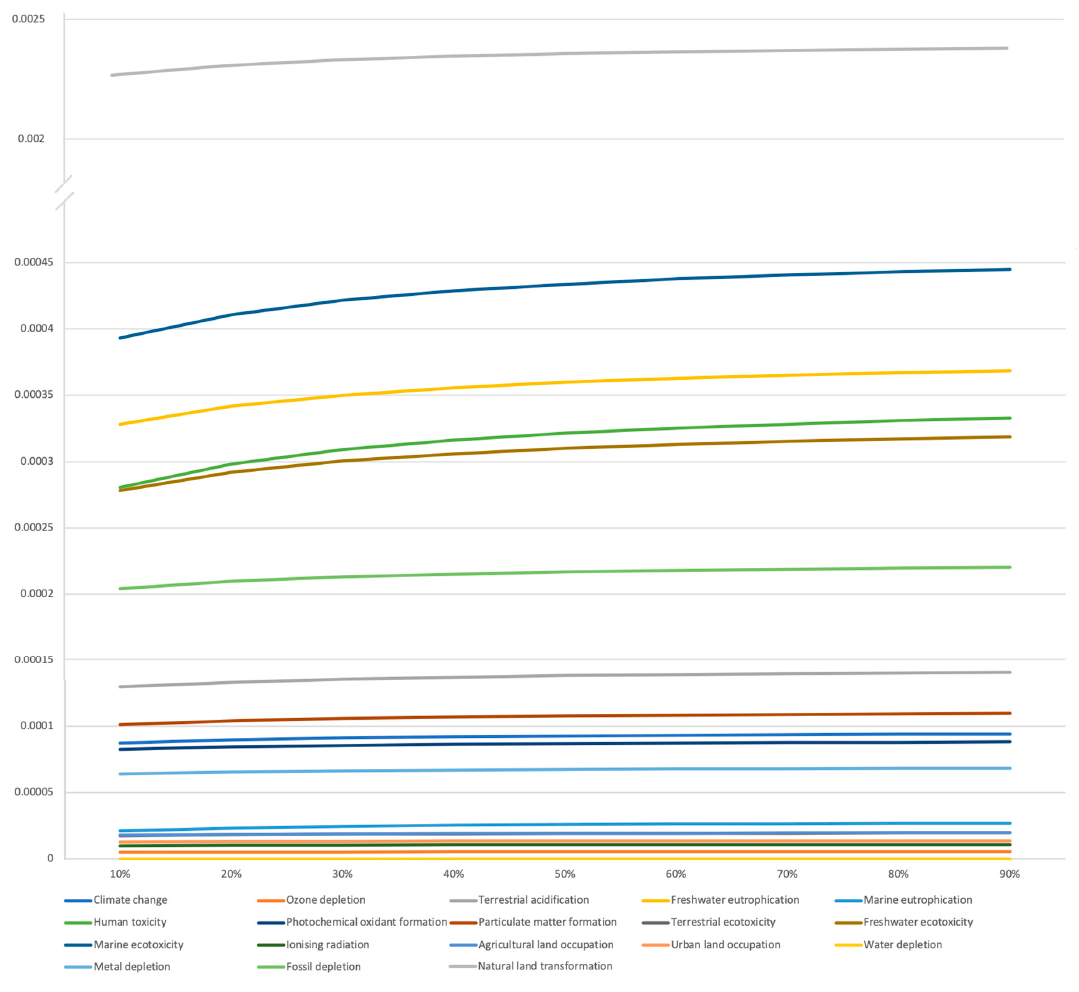
Figure 4. Normalisation results for the various assumptions—extracted from SimaPro (Pré 2018) and